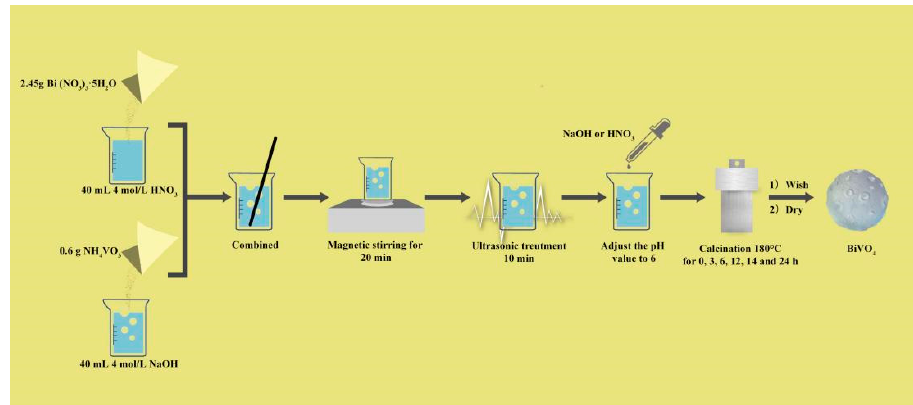
Figure 1. BiVO 4 preparation flow chart.